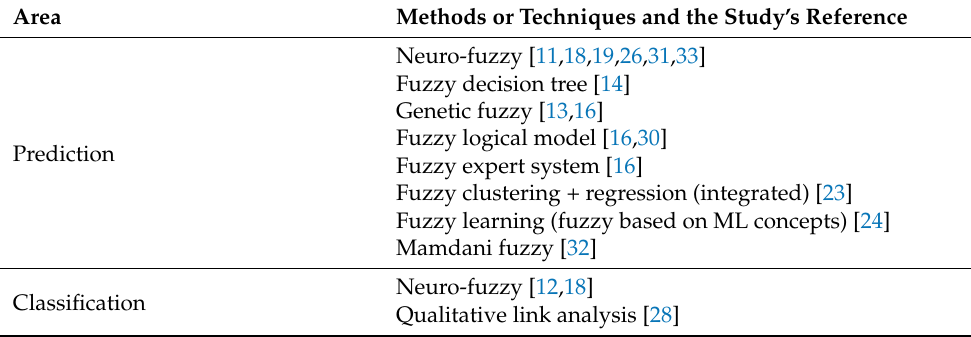
Table 1. The related